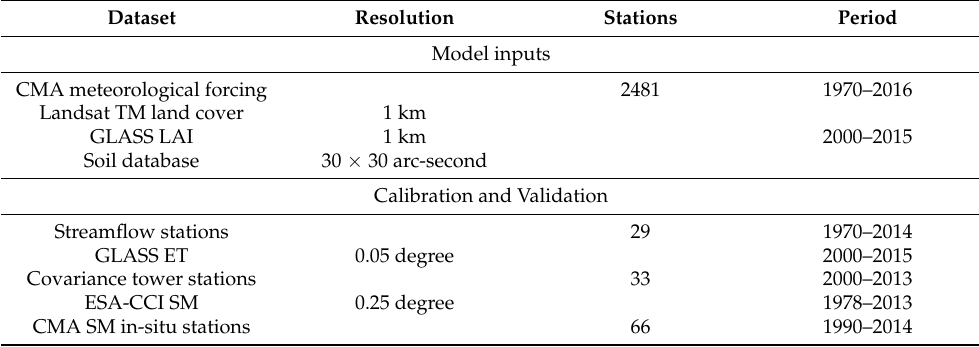
Figure 1. Distribution of ( a ) meteorological stations and ( b ) in-situ runoff stations, SM, and ET stations. Table 1. Summary of datasets used in this